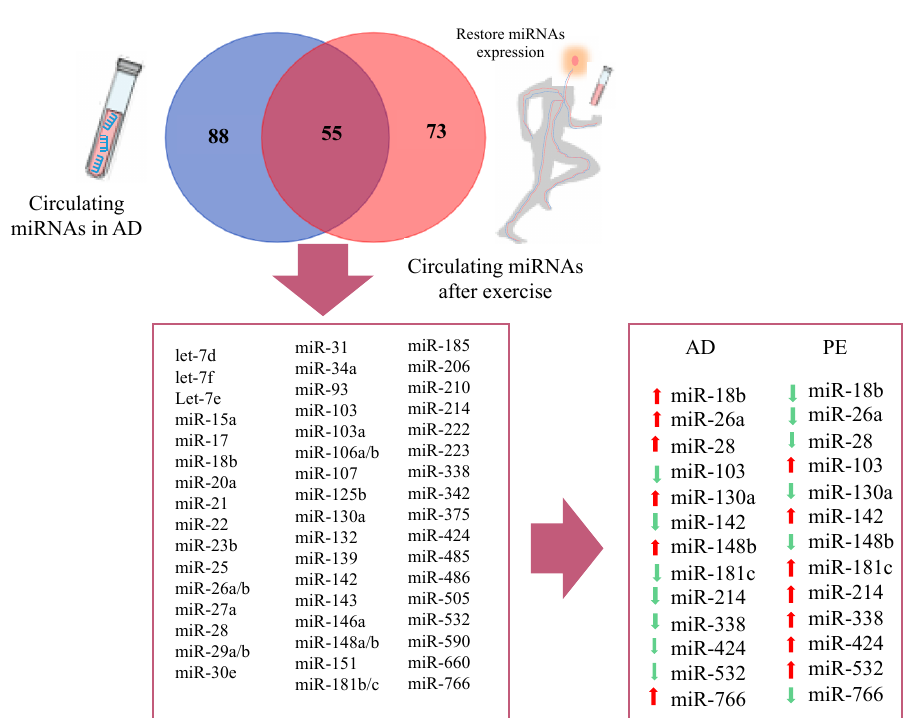
Figure 3. Venn diagram representing overlap of miRNAs in AD brain and restored miRNAs after physical exercise.